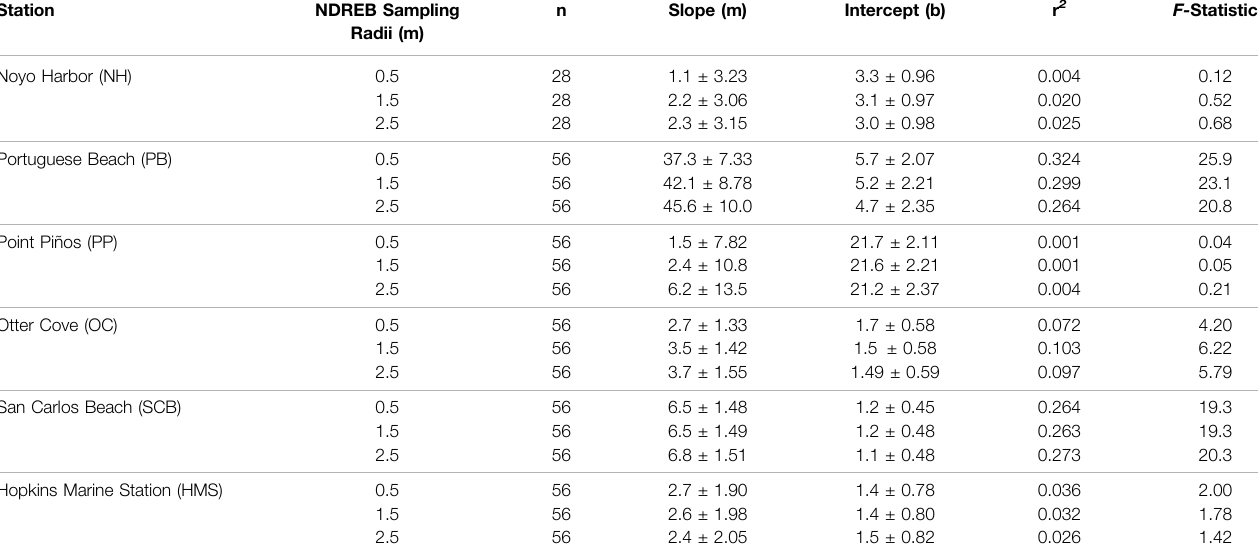
TABLE 6 | Original Least Squared (OLS) regression statistics from Figure 7 with slope and intercept values ± 1 standard deviation. Station F- Statistic